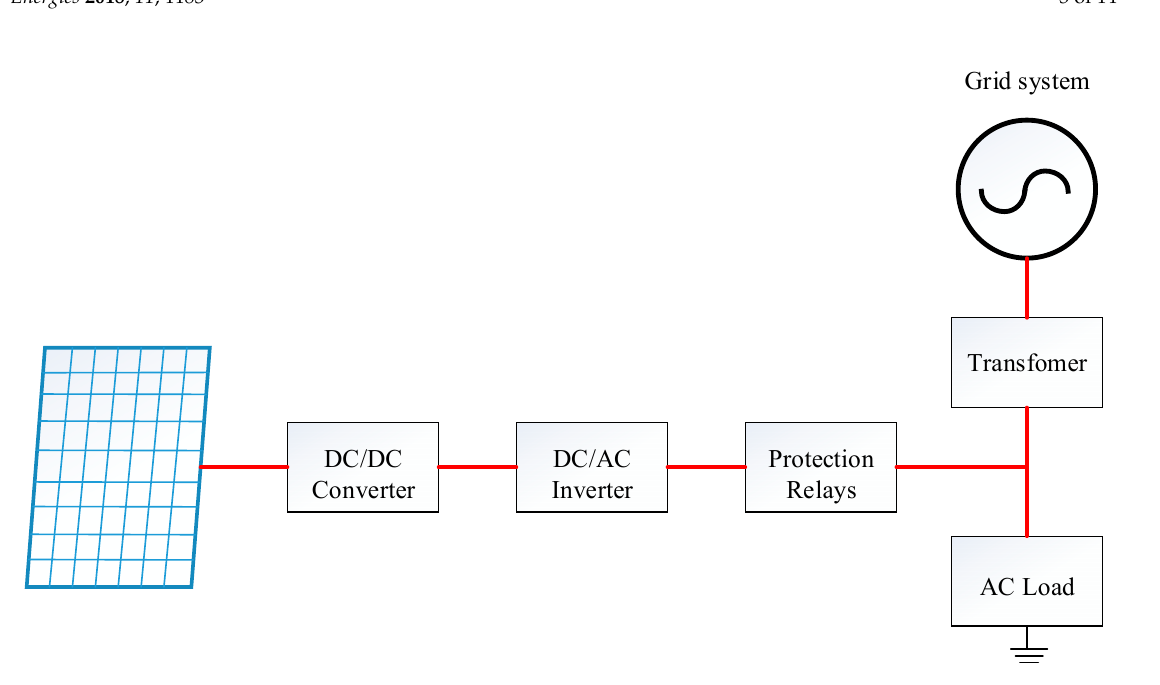
Figure 1. Photovoltaic power generation system and grid-connected network.